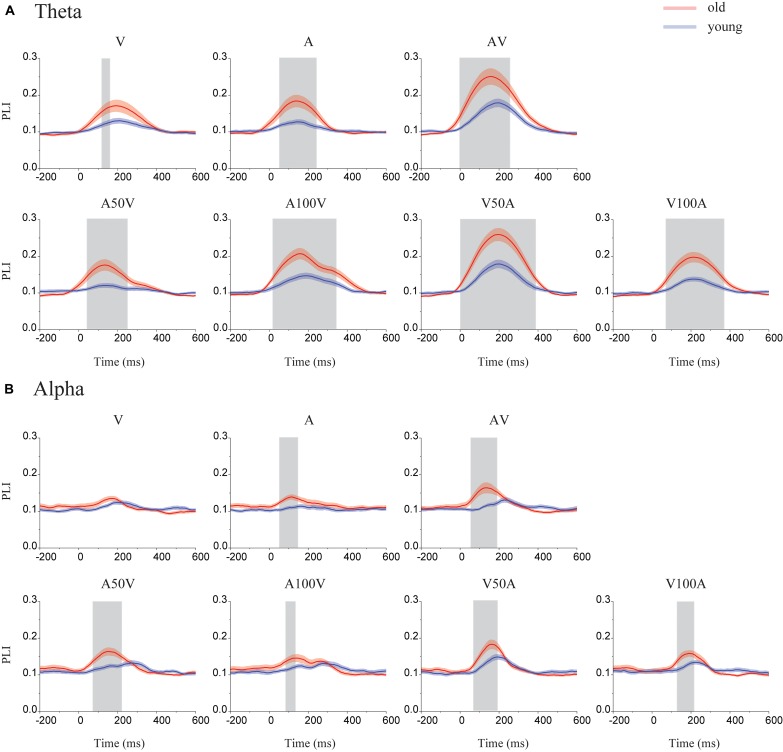
Time courses of the mean PLI in the theta and alpha bands. (A) In the theta band, the time courses of the mean PLI for each group in each condition (including the A, V, AV, A50V, A100V, V50A, and V100A conditions). (B) In the alpha band, the time courses of the mean PLI for old (red line) and young adults (blue line) included time points of 200 ms before stimulus onset and 600 ms after stimulus onset. The shaded areas indicate the time periods with significant group differences (permutation test, p < 0.05, corrected).